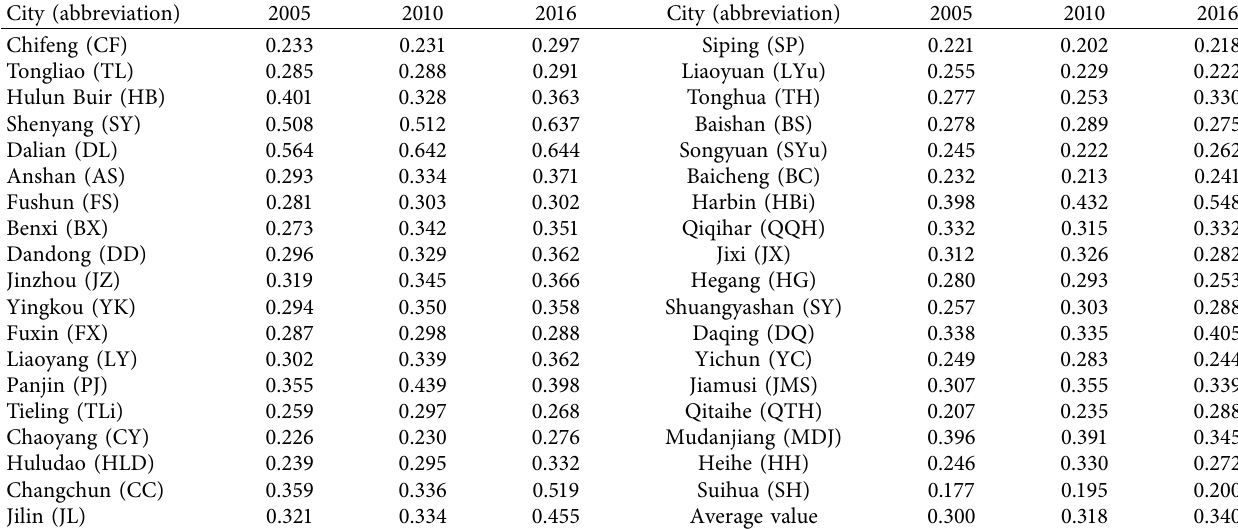
Table 2: Values of urban economic resilience in Northeast China in 2005, 2010, and